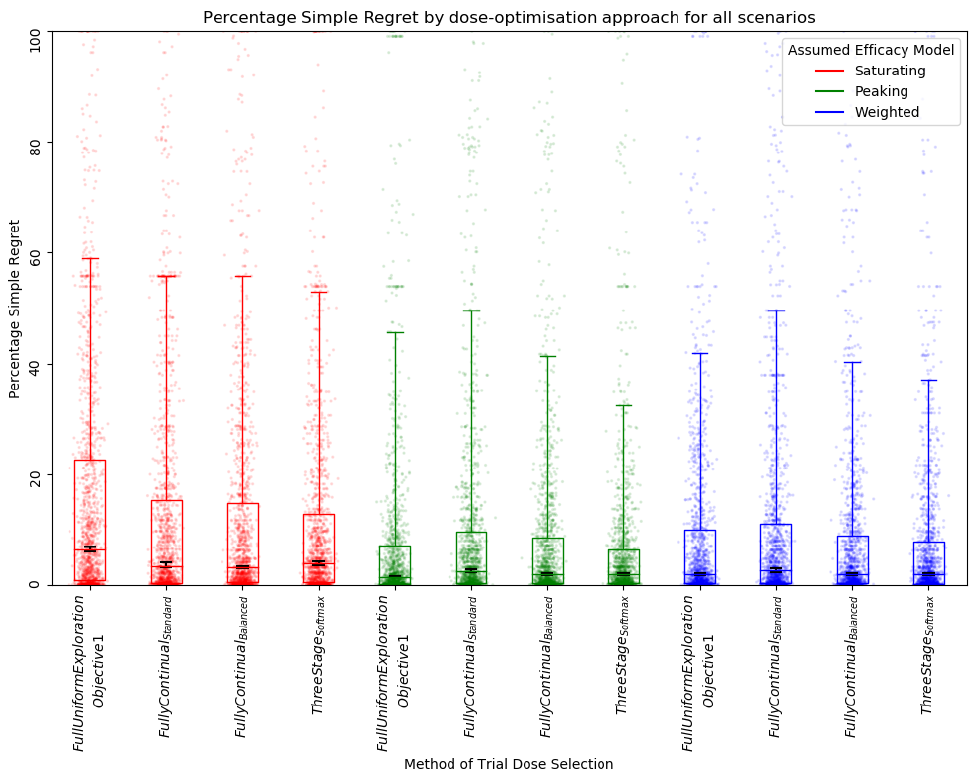
Figure 10. Percentage simple regret (PSR) for all scenarios by assumed efficacy model and trial dose-selection method. Trial size was 30. Individual points represent PSR for a single simulated clinical trial using that dose-optimisation approach for one of the 14 scenarios. The middle line of each boxplot is the median value; the box marks the 25th and 75th percentiles, and the whiskers mark the 5th and 95th percentiles of the data. A lower PSR denotes a more optimal final dose. Black lines represent the 95% confidence interval for the median of each distribution [47]. The distributions of PSR for the approaches that assumed a saturating model were different to the distributions of the approaches that assumed a peaking or weighted efficacy mode to a statistically significant extent at the p = 0.05 threshold according to the Kolmogorov – Smirnov test. For further details on statistical significance, see Supplementary S12.